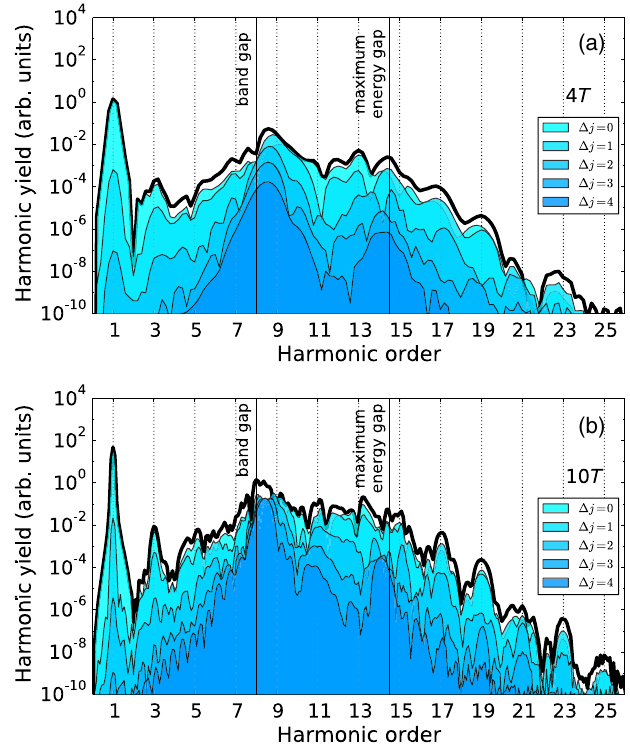
FIG. 3. Panels (a) and (b) depict the full harmonic spectra for two different laser time durations, N ¼ 4 and 10, respectively (thick black lines), calculated within the Wannier-Bloch ap- proach. Furthermore, color regions show the harmonic contribu- tions of the different relative electron-recombination atomic sites in the spatially periodic lattice structure Δ j ¼ 0 ; 1 ; … ; 4 . The black vertical lines (read from left to right) point out the band-gap harmonic and the expected cutoff harmonic orders, respectively. The laser-pulse peak intensity is I 0 ¼ 5 × 10 11 W = cm 2 , the carrier wavelength λ 0 ¼ 3 . 0 μ m, and its CEP is φ The calculations are carried out for laser polarization in the Γ − A